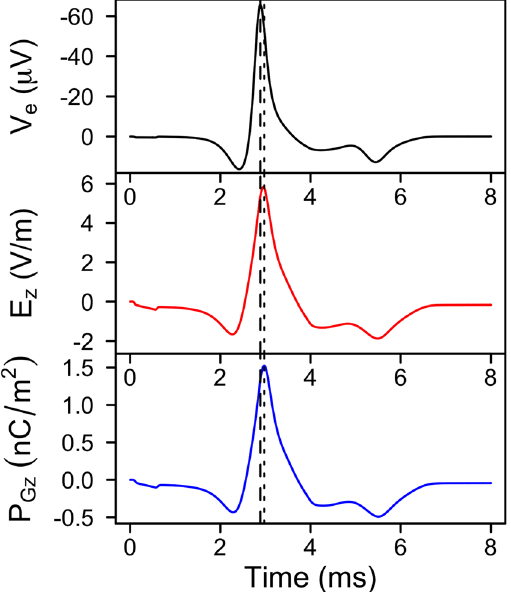
Figure 7. Simulated temporal performance of the optrode at a single channel. Comparison of temporal changes in extracellular potential probed at the neuron ( V e ), electric field across the liquid crystal (LC) layer ( E z ), and electric polarisation of the LC ( P Gz ) in the direction perpendicular to the optrode’s circular surface, measured directly below the neuron probe point.